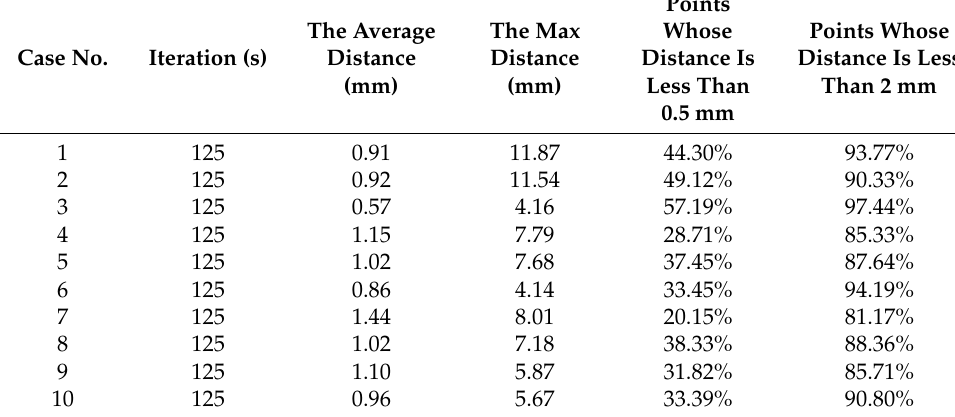
Table 7. Evaluation results.